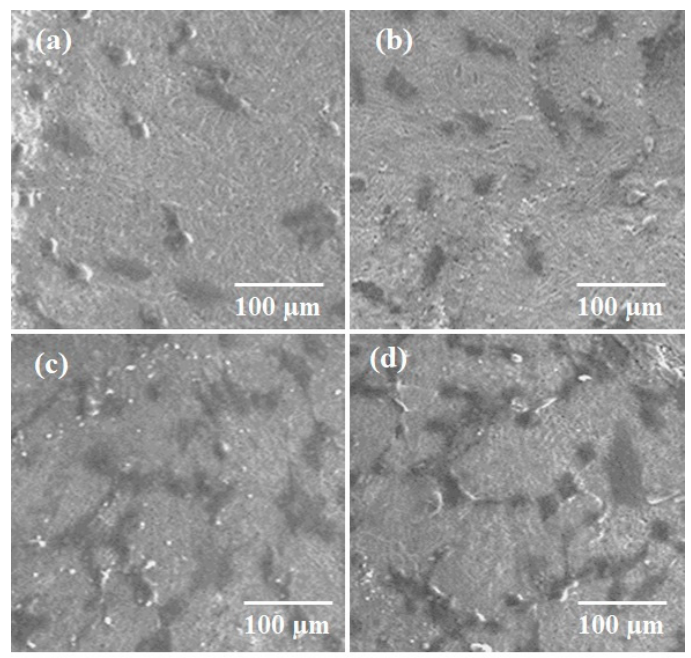
Figure 12. ( a – d ) FESEM images of MG-63 osteoblast cell proliferation of Mn-HAp/ZnO bilayer coating on 316L SS substrate at ( a ) 3, ( b ) 7, ( c ) 14 and ( d ) 21 days.